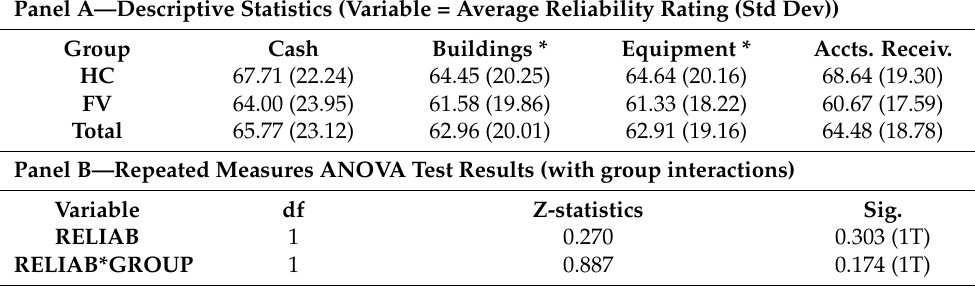
Table 6. Analysis of Reliability of Measurement Concepts.